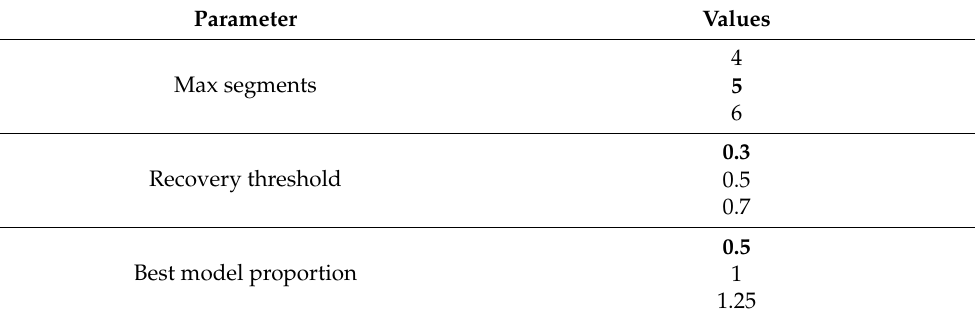
Table 2. List of LandTrendr parameters.